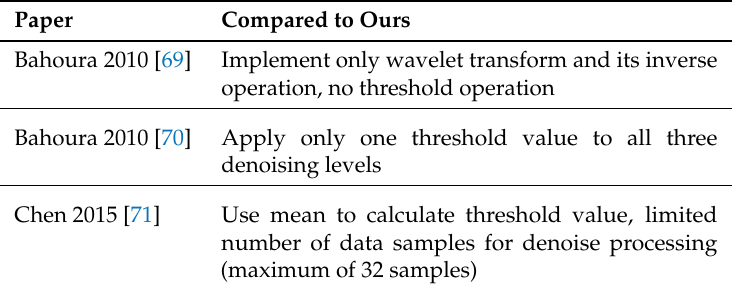
Table 5. Comparison with DWT